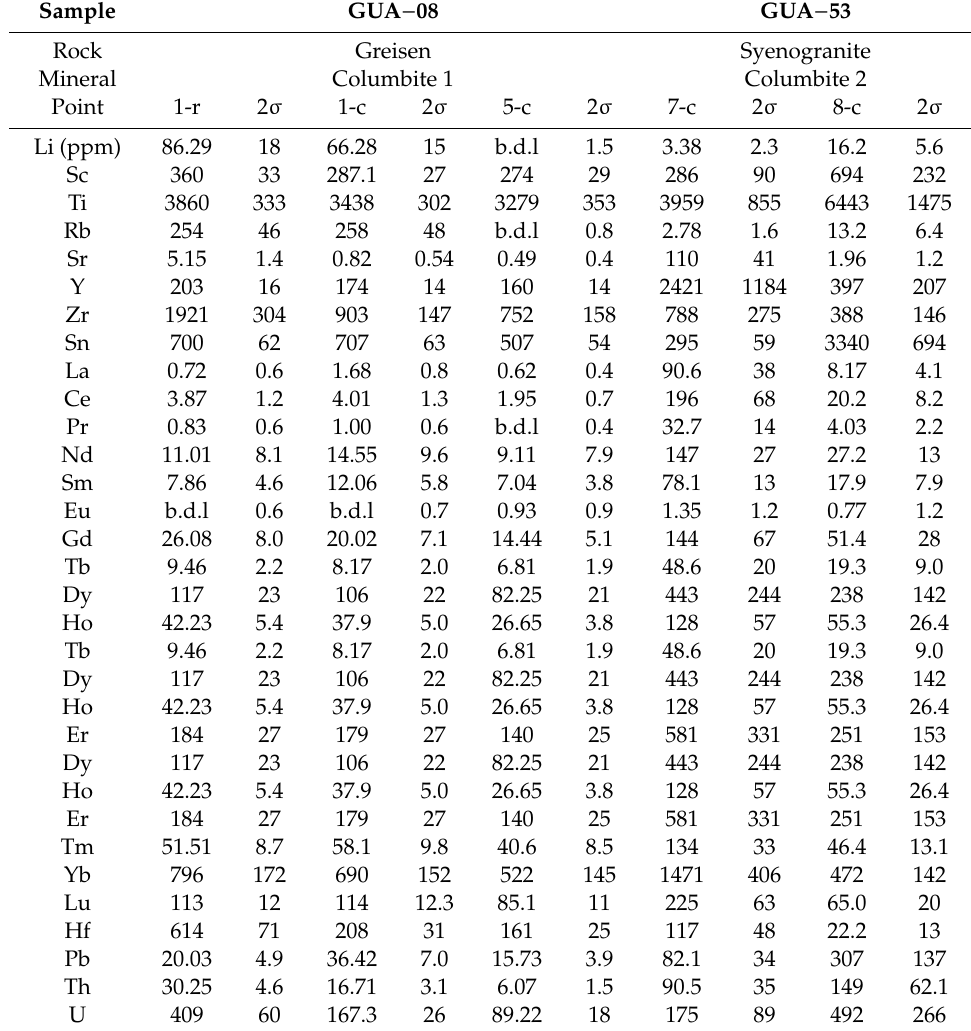
Table 3. Representative LA-ICP-MS trace element analyses of the Desemborque columbite